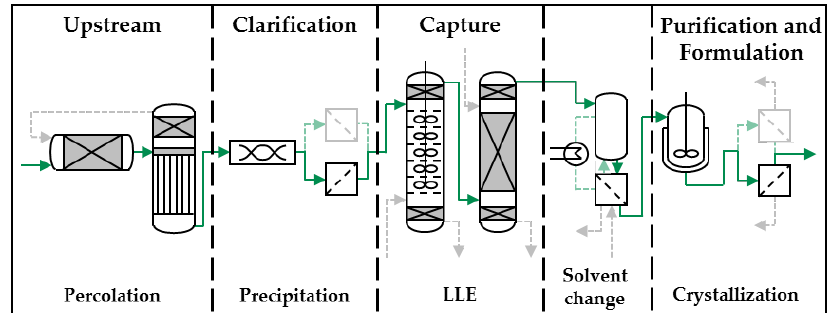
Figure 14. Reduced purification process of artemisinin.